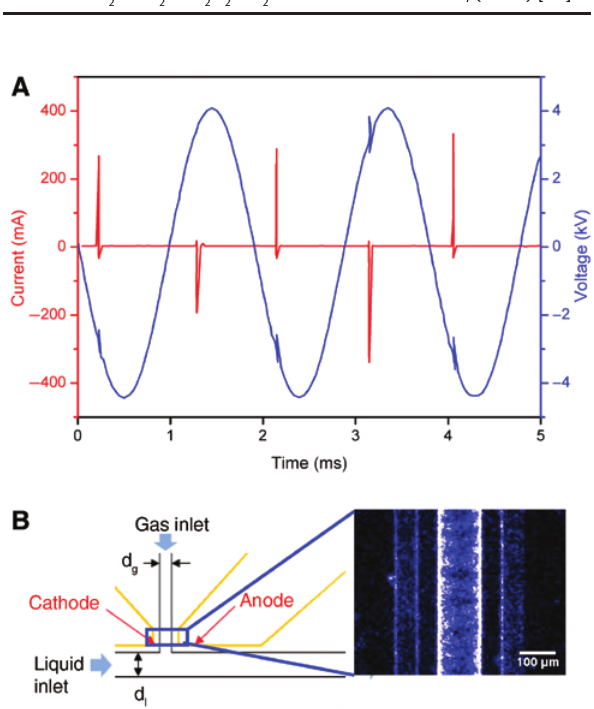
Figure 6: Electrical diagnosis (A) and optical diagnosis (B) of the